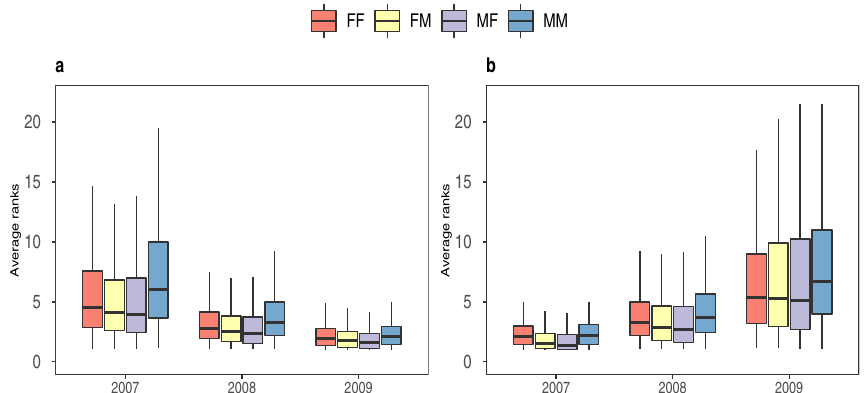
Figure 1. Change in the rank of alters during the formation or decay of ego-alter relationships over a 3 year period. The ranks have been calculated monthly, then averaged over 12 months for each year and a summary of their progressive increase/decrease over a span of three years are plotted in a boxplot for ( a ) the set of ego- alters forming close relationships and ( b ) another set of ego-alters decaying from close relationships. The black horizontal lines in the middle represent the median of the distribution. The box plot includes all the values within the range of the 25th and 75th percentile and the ends of the whiskers represent the maximum and the minimum ranks excluding outliers. The red box represents ranks of females and blue box represents the same for males in their respective same-gender egocentric networks. The yellow box represents the ranks of males in female egocentric networks and violet box represents the same for females in a male egocentric networks. We find that for all years in both cases, a male’s rank among his male friends is consistently lower than other groups indicating that female friendships and opposite-gender friendships generally form stronger bonds than male